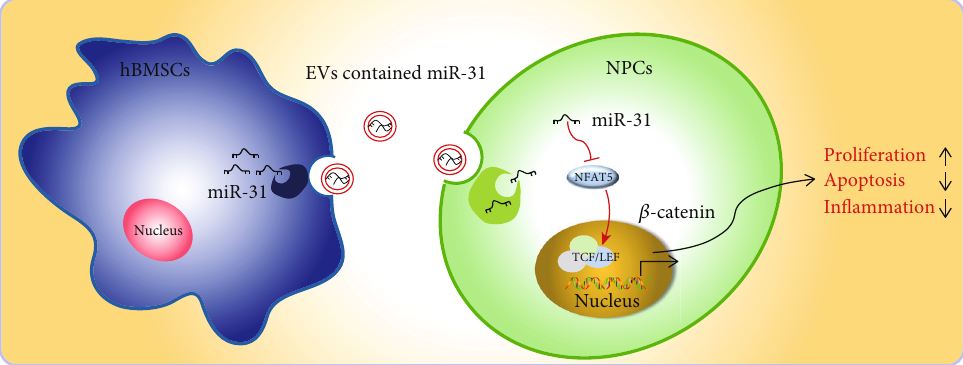
Figure 9: Schematic diagram of the mechanism by which miR-31 in hBMSC-EVs a ff ects IDD. hBMSC-EVs transferred miR-31 to NPCs where miR-31 targets NFAT5 and reduces the expression of NFAT5 and activates the Wnt/ β -catenin pathway, thus promoting the proliferation of NPCs, inhibiting their apoptosis, and reducing the release of cellular in fl ammatory factors, ultimately alleviating IDD in